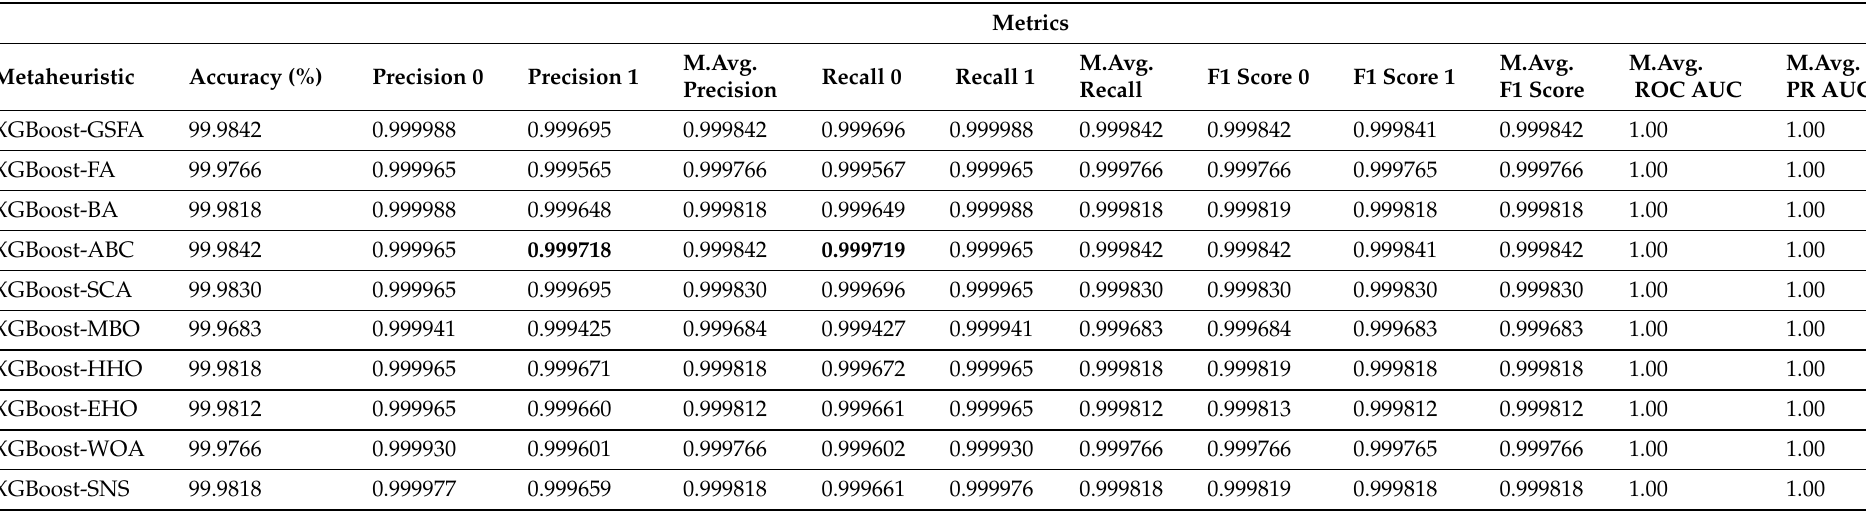
Table 13. XGBoost Credit Card Fraud with the SMOTE—detailed